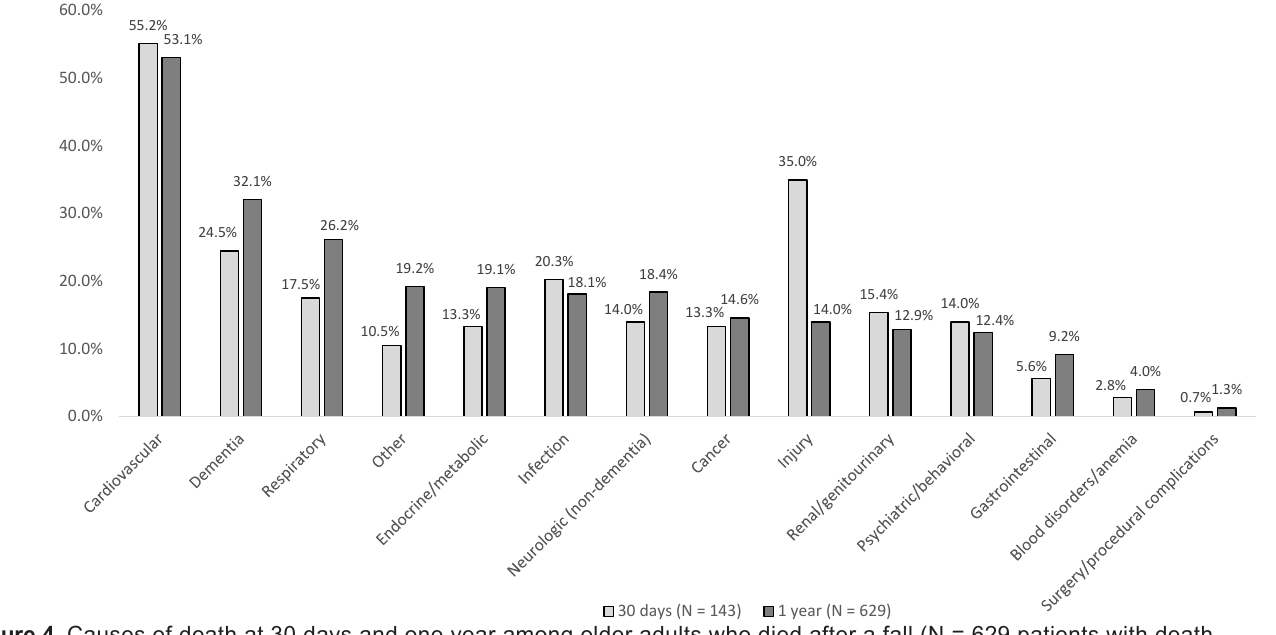
Figure 4. Causes of death at 30 days and one year among older adults who died after a fall (N = 629 patients with death certificate